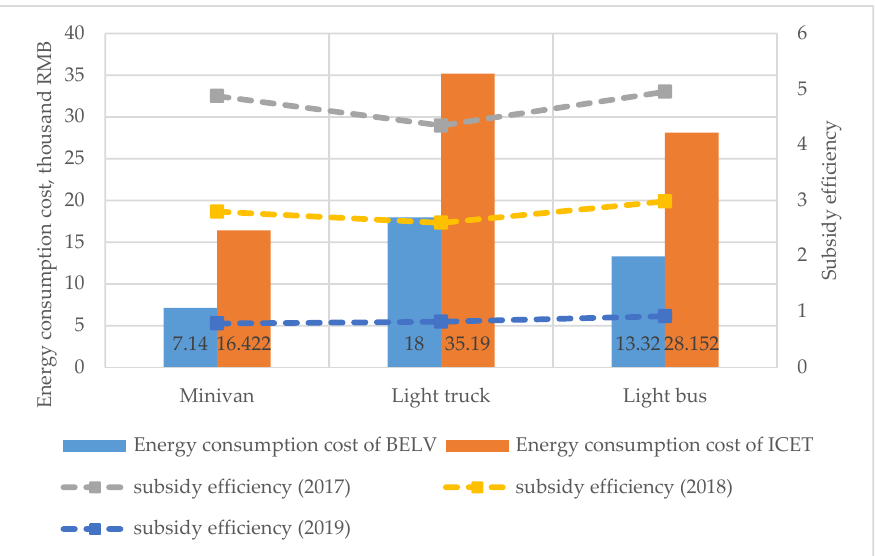
Figure 15. Energy consumption comparison between BELVs and internal combustion engine trucks (ICETs).